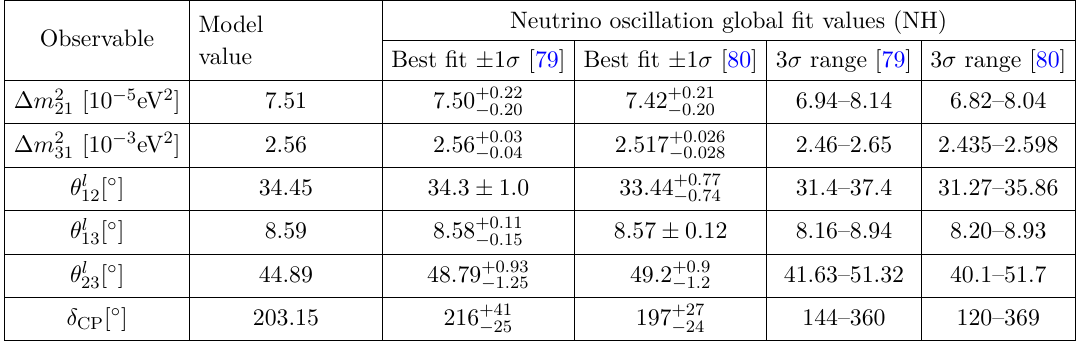
Table 5 . Model and experimental values of the neutrino mass squared splittings, leptonic mixing angles, and CP-violating phase. The experimental values are taken from refs. [79,